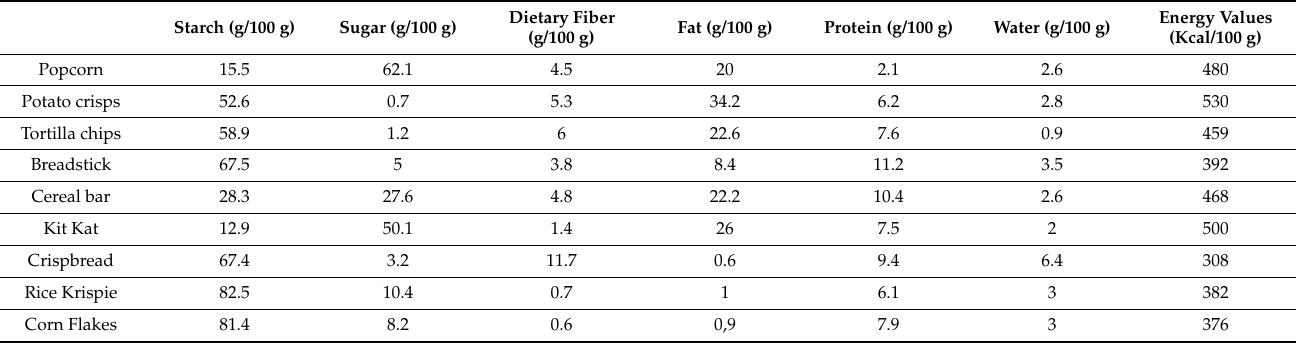
Table A1. Composition of selected ready-to-eat snacks.